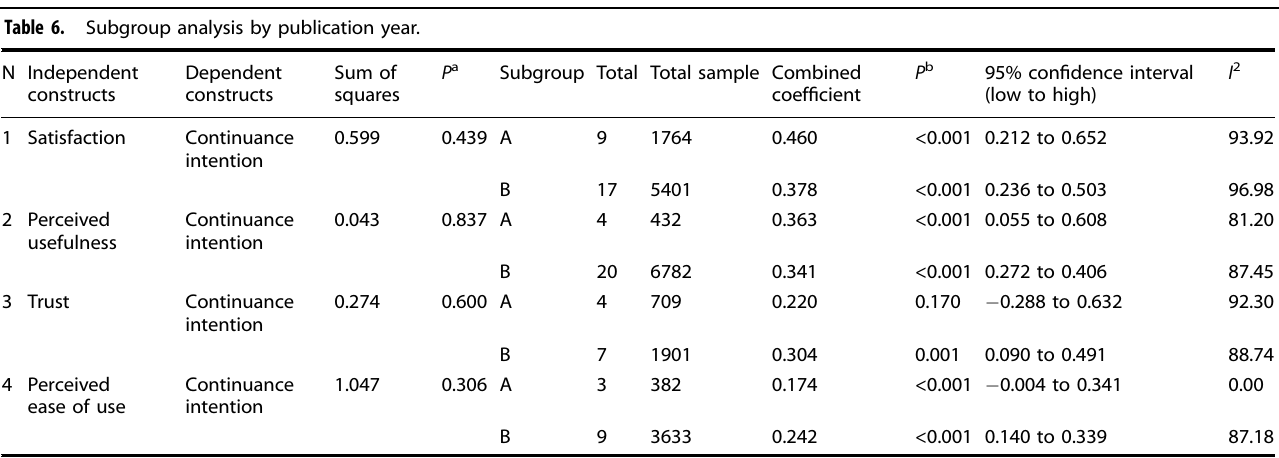
Table 6. Subgroup analysis by publication